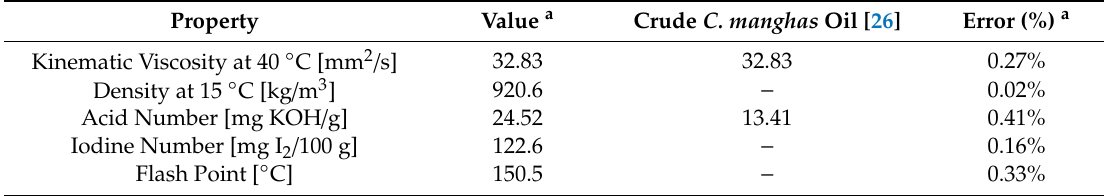
Table 5. Physicochemical properties of the CCMO